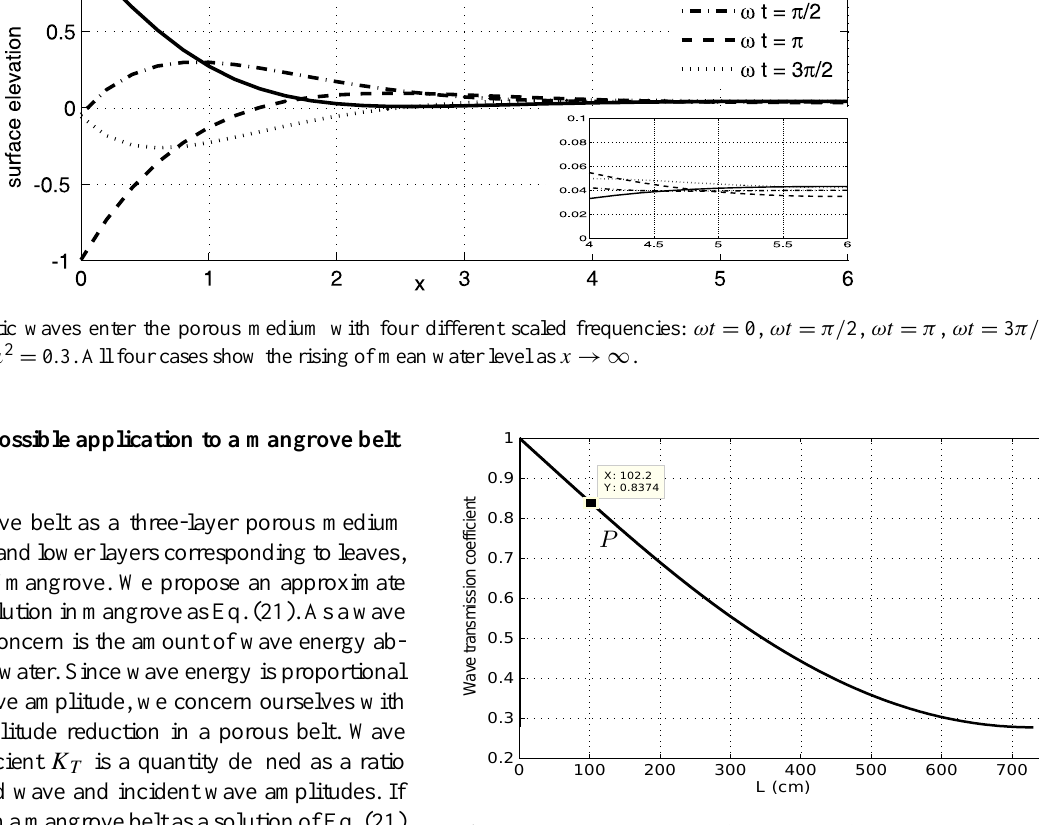
Fig. 4. Wave transmission coefficient curve from numerical compu- tation using ε = µ 2 = 0 . 3.